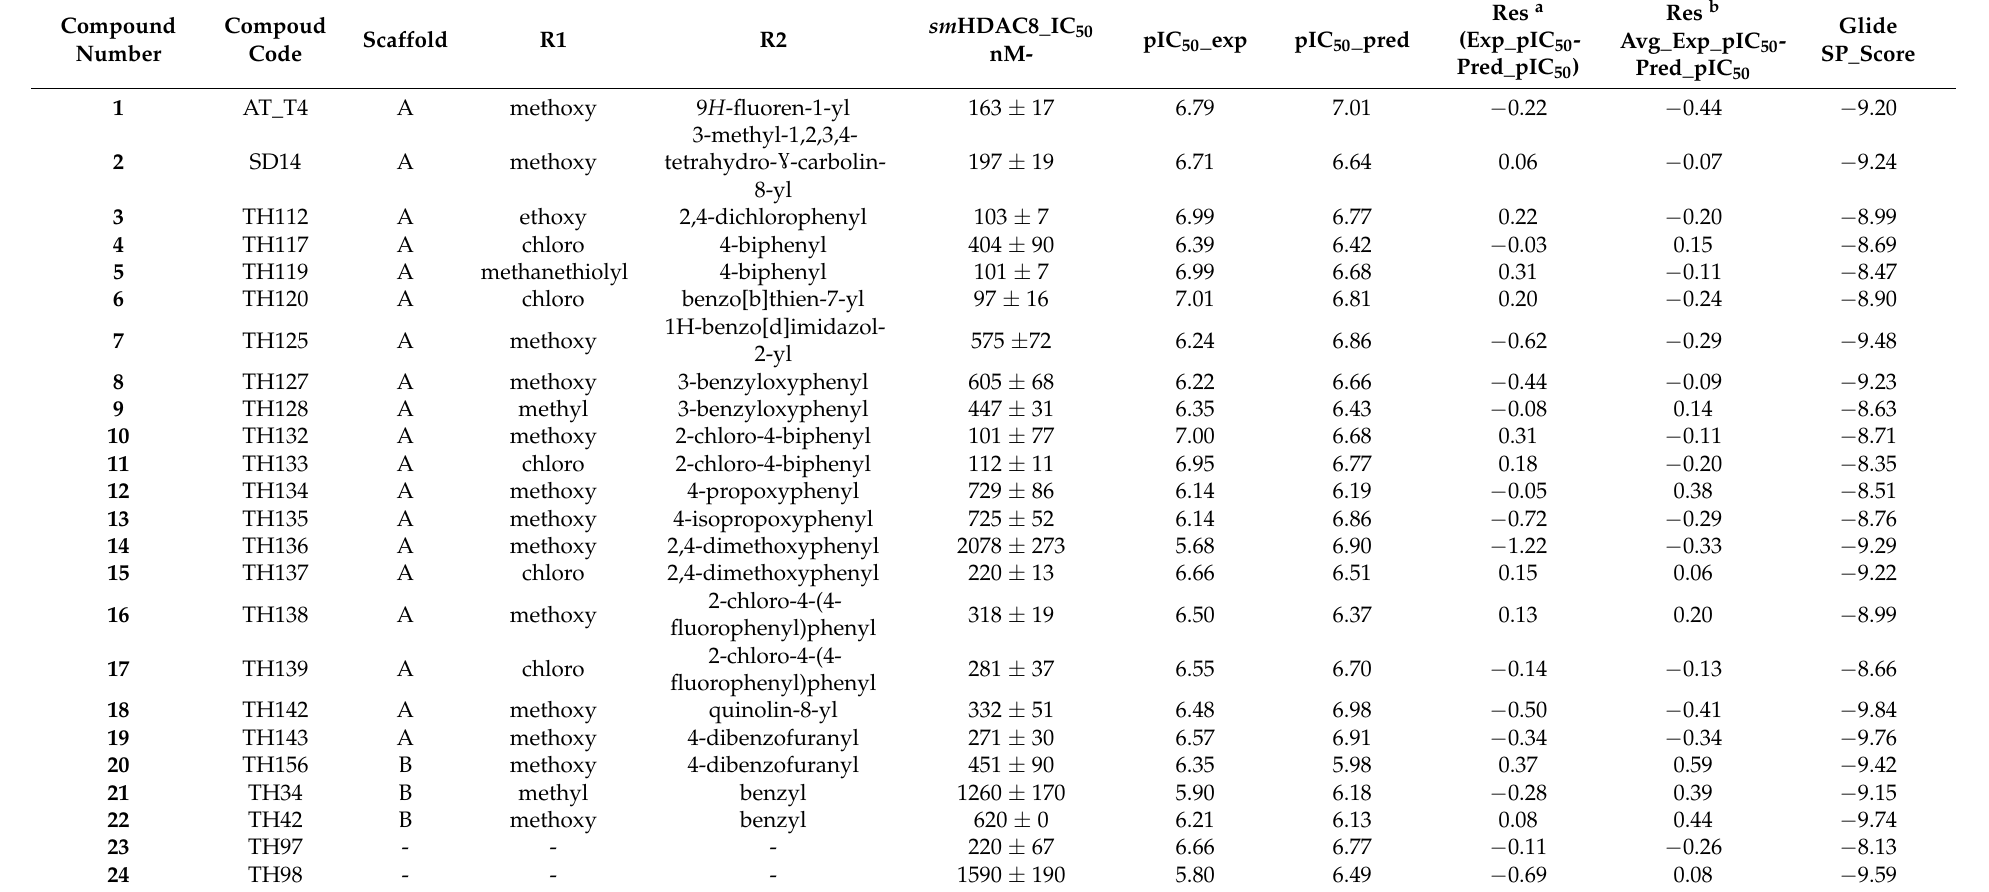
Table 3. Chemical structure and prediction of test set